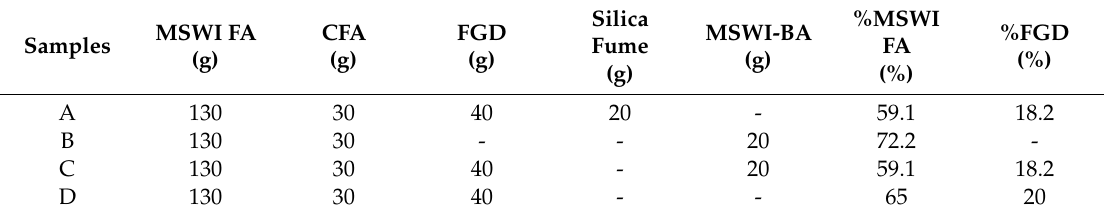
Table 1. Samples description. MSWI FA: municipal solid waste incineration-fly ash; CFA: Coal Fly Ash; FGD: Flue Gas